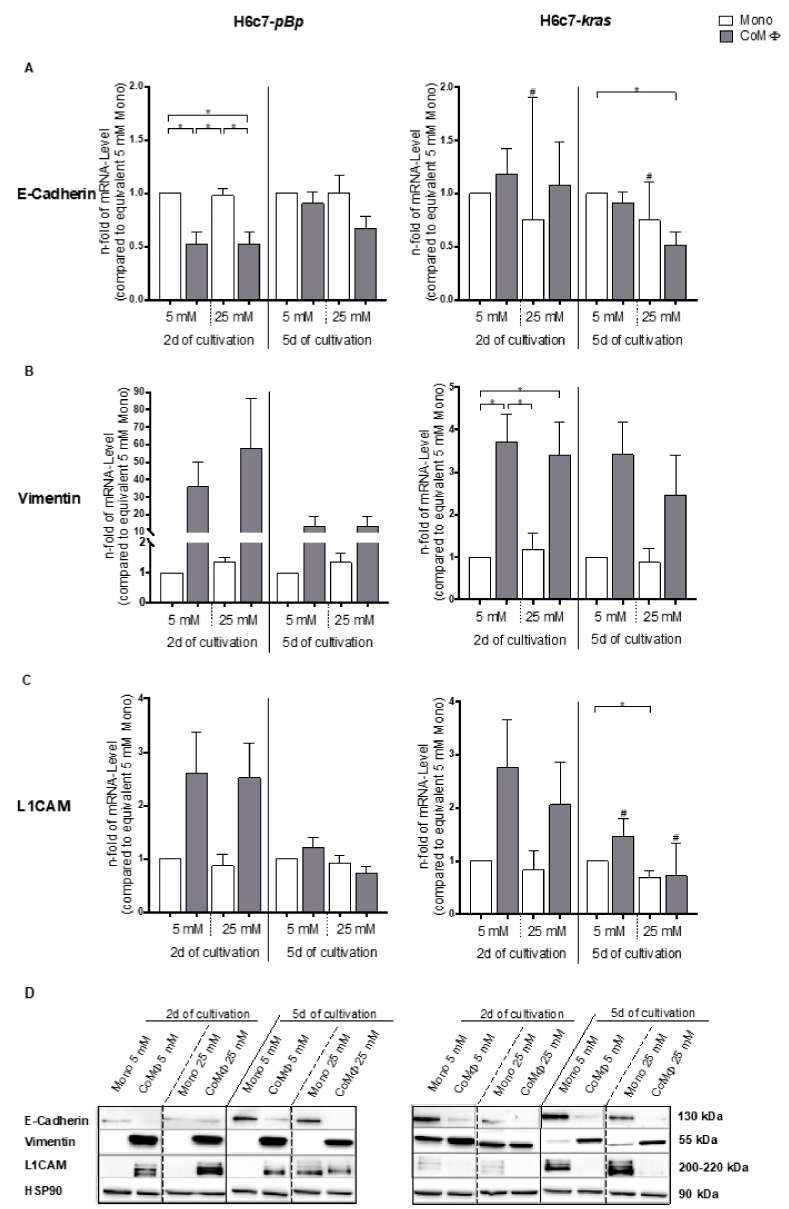
Figure 5. The presence of macrophages and hyperglycemia impacts expression of EMT markers on mRNA and protein level in PDEC. H6c7- pBp or H6c7- kras cells were cultivated in mono- or coculture with M1-polarized macrophages (M Φ ) under normo- or hyperglycemic conditions (5 or 25 mM of D -glucose) for 2 or 5 days. The epithelial cells were separated from direct coculture with macrophages via CD11b-MACS depletion of M1-M Φ or harvested from monoculture and used for qRT-PCR and Western blot analysis. The relative mRNA levels of E-cadherin ( A ), Vimentin ( B ) and L1CAM ( C ) are depicted for both cell lines. They are normalized to the housekeeping gene GAPDH and presented as n -fold expression compared to the monocultured 5 mM sample from the equivalent cultivation timespan. Normally distributed data are presented as mean and standard error of mean; not normally distributed data (indicated via #) are shown as median and interquartile range. * 0.05 > p > 0.0332; n = 4 for 2-day culture; n = 7 for 5-day culture. Protein levels of the indicated EMT markers are depicted in ( D ), Hsp90 was used as loading control. A representative of three independent experiments is